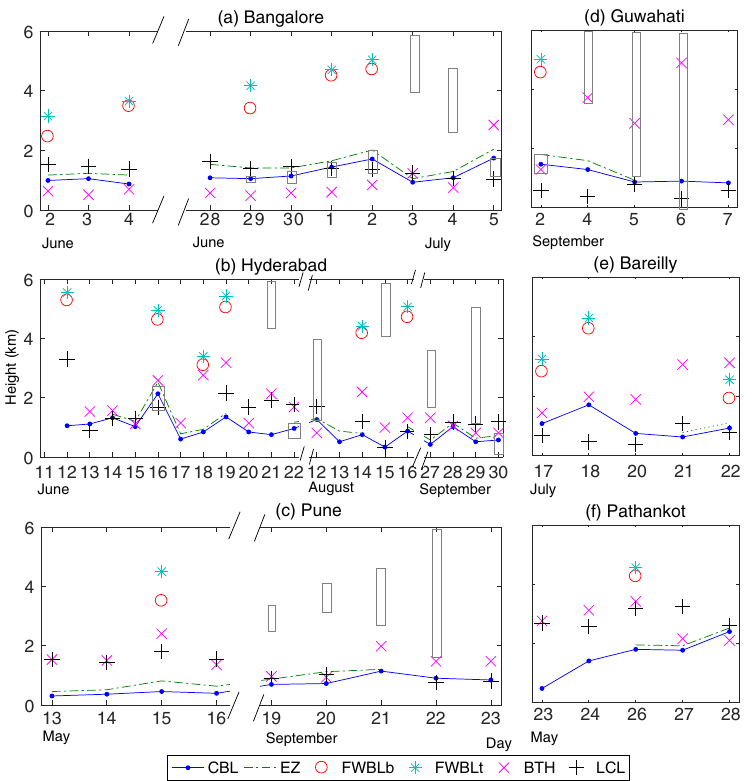
Figure 8. Time series of the CBL, EZ, FWBL b , FWBL t , LCL height, and the BTH observed over (a) Bangalore, (b) Hyderabad, (c) Pune, (d) Guwahati, (e) Bareilly, and (f) Pathankot during the Indian summer monsoon season as listed in Table 1. The grey rectangular box indicates the cloud layer representing the location with RH >